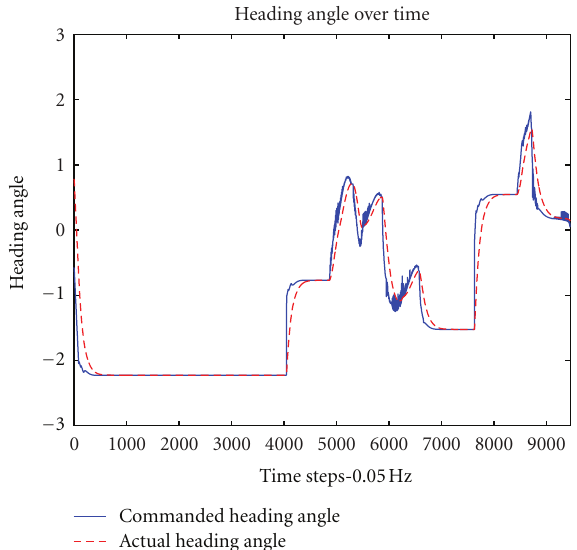
Figure 17: Extra distance traversed for the approximate solutions in simple (least dense)